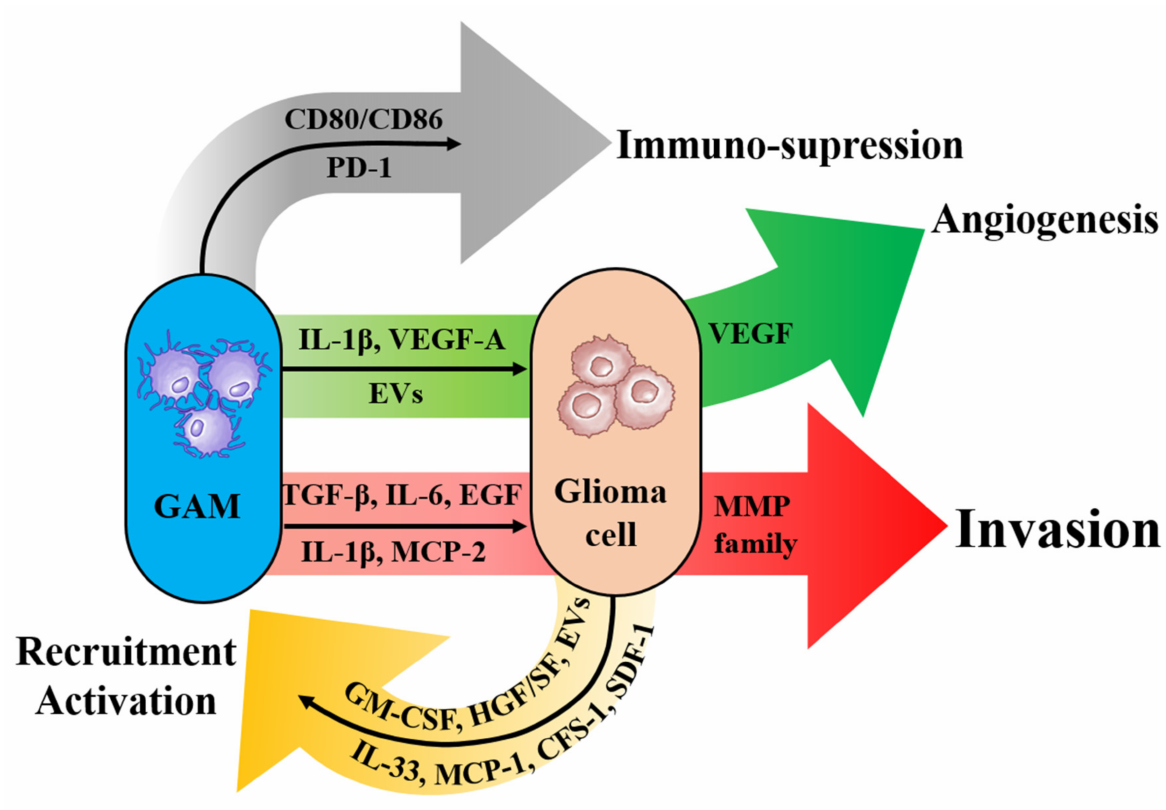
Figure 4. Scheme of the mechanisms of glioma-associated macrophages/microglia (GAM). GAM plays a major role in glioma invasion, angiogenesis, and immunosuppression. The main enzyme contributing to glioma cell invasion is the matrix metalloproteinases (MMP) family. The activation of vascular endothelial growth factor (VEGF) associates with angiogenesis, and programmed cell death-1 (PD-1) is the one of the key molecules for immunosuppression. Glioma cells are involved in the recruitment and activation of GAMs. GAM–glioma cell crosstalk is caused by various chemoat- tractant molecules and extracellular vesicles (EVs). Abbreviation: CD; clusters of differentiation, CFS-1; colony stimulating factor-1, EGF; epidermal growth factor, GM-CSF; granulocyte-macrophage colony stimulating factor, HGF; hepatocyte growth factor, IL; interleukin, MCP; monocyte chemoat- tractant protein, MMP; matrix metalloproteinase, SDF-1; stroma-derived factor-1, TGF; transforming growth